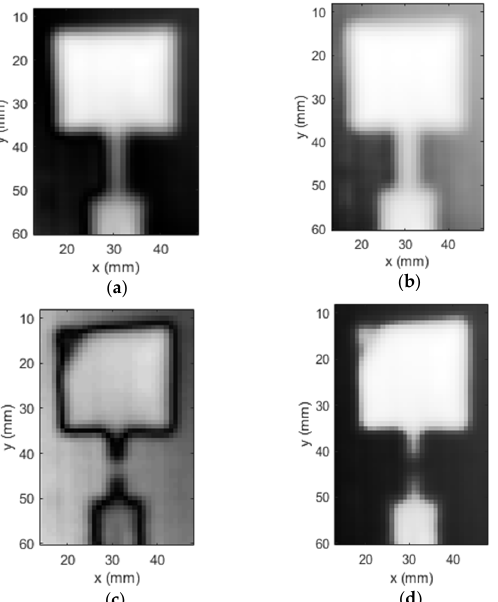
Figure 9. Magnitude and phase images of the ( a , b ) healthy and ( c , d ) damaged C-band patch antenna fabricated using copper foil, produced by the UHF probe.